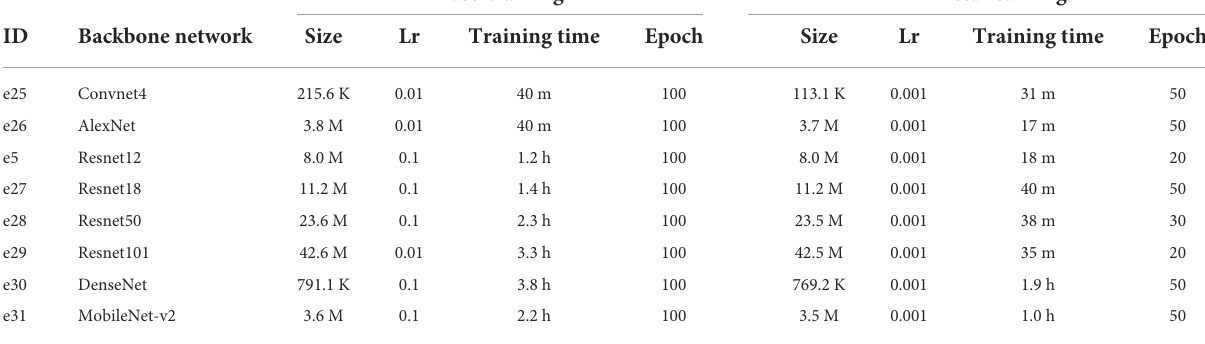
TABLE 7 The experiment efficiencies of different backbone networks.